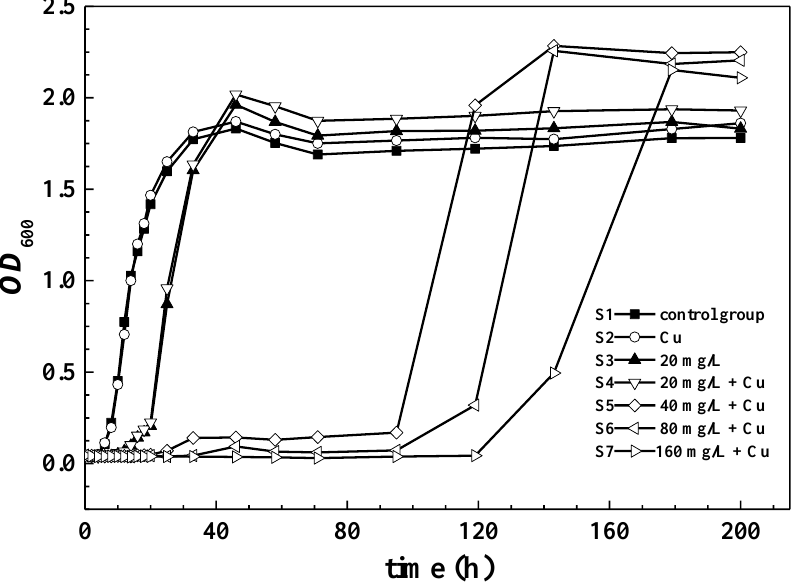
Figure 1. The optical density of GQ-9 when exposed to 5 mg/L Cu 2+ and different concentrations of perfluorooctanoic acid (PFOA).